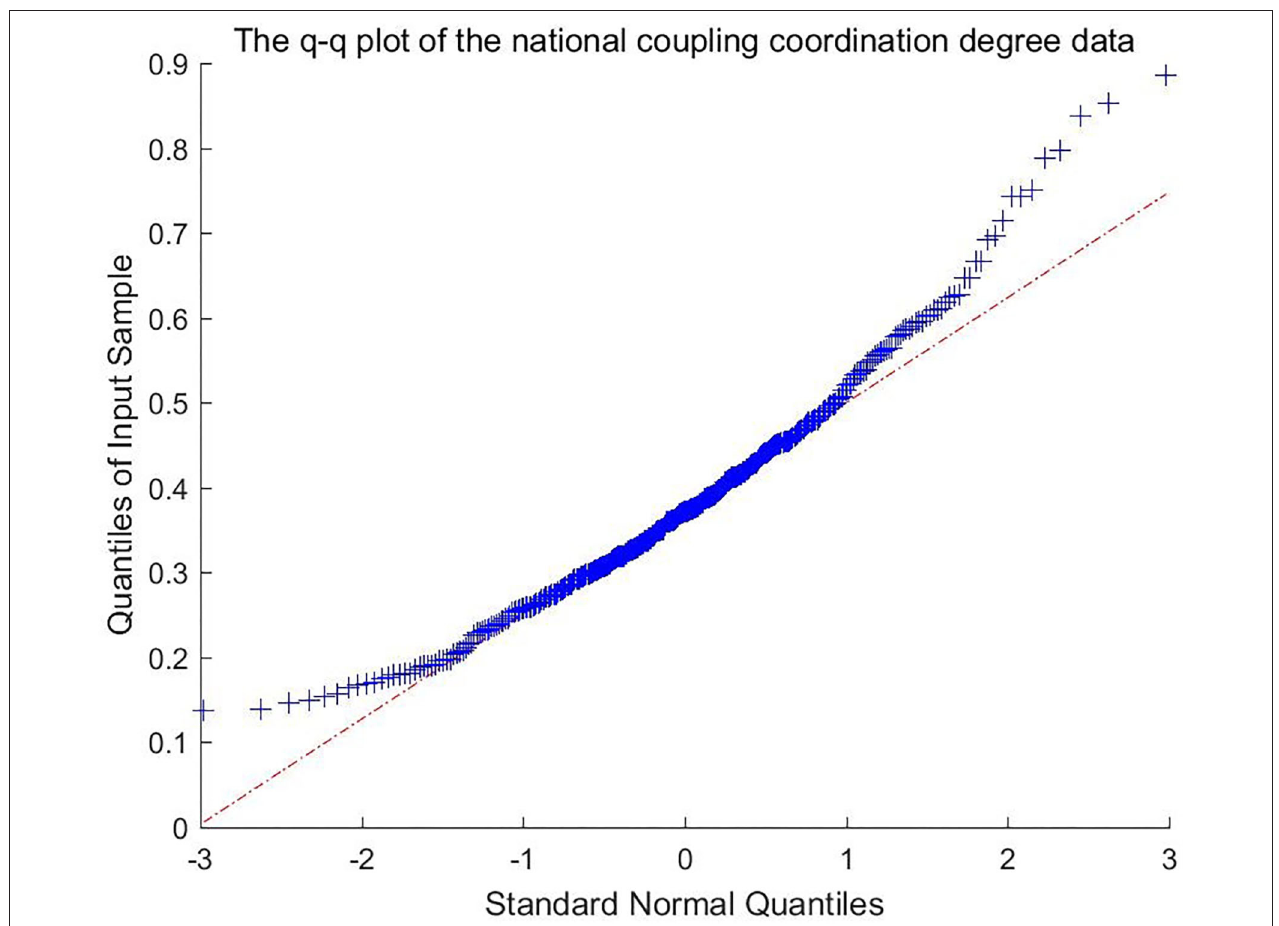
FIGURE 2 | The q-q plot of the national coupling coordination degree